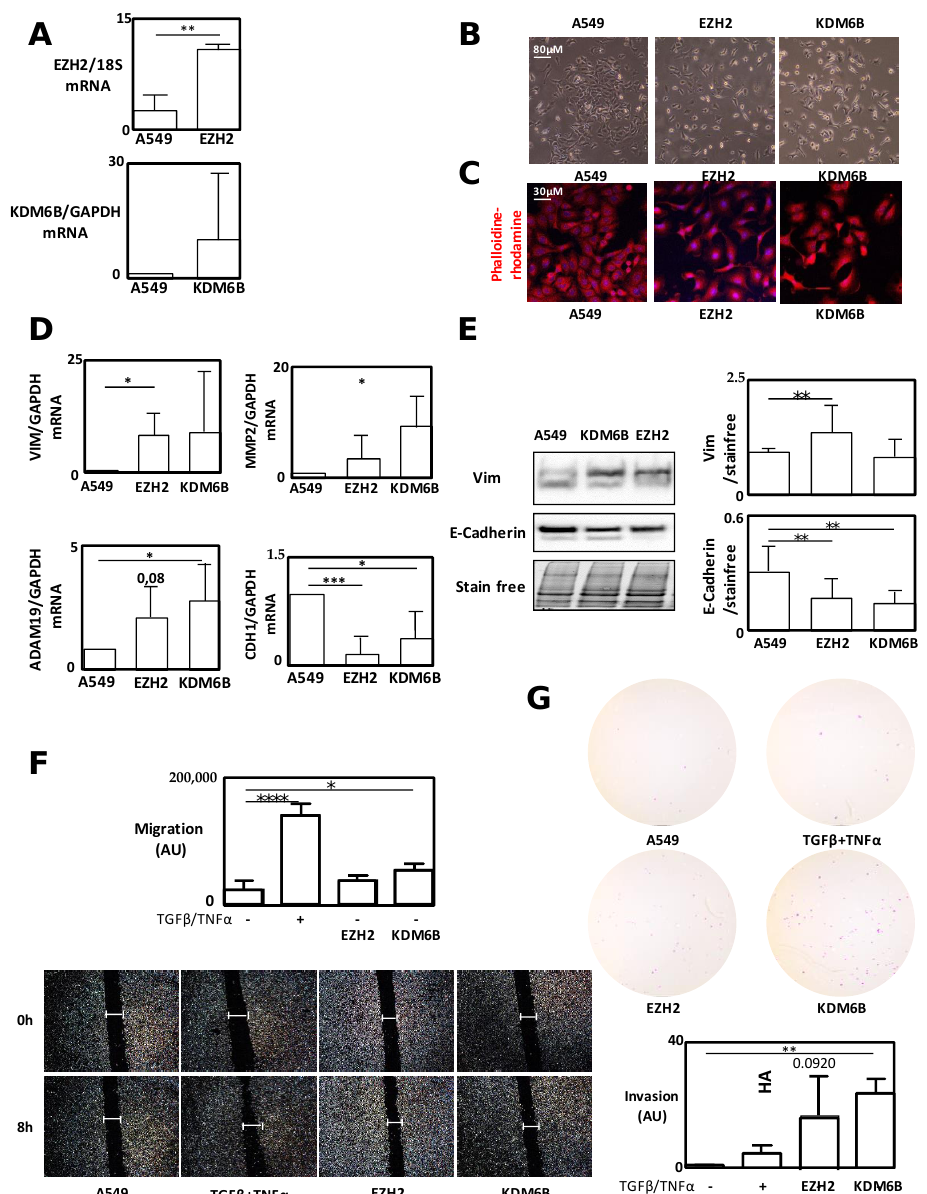
Figure 2. Overexpression of EZH2 and KDM6B induced EMT. ( A ) mRNA levels of EZH2 and KDM6B after stable transfection of A549 with EZH2- or HA-KDM6B-expressing vectors. ( B ) Representative images showing the phenotype of A549 WT cells and A549 cells overexpressing EZH2 or KDM6B (EVOS ™ 10 × Objective). ( C ) Phalloidin-rhodamin staining of A549 WT or A549 cells overexpressing EZH2 or KDM6B. ( D ) Quantification of Vimentin , CDH1 , ADAM19 , and MMP2 expression levels using qRT-PCR in A549 cells treated with TGF β / TNF α or in cells overexpressing EZH2 or KDM6B. ( E ) Western-blot analysis showing a decrease in E-Cadherin expression in A549 cells overexpressing KDM6B.( F )WoundhealingexperimentsinA549cellstreatedwithTGF β / TNF α orincellsoverexpressing EZH2 or KDM6B and the relative quantification of the e ff ects observed (EVOS ™ 4 × Objective). ( G ) Invasion tests in A549 cells treated with TGF β / TNF α or in cells overexpressing EZH2 or KDM6B (EVOS ™ 4 × Objective). * = 0.01 < p < 0.05; ** = 0.005 < p < 0.01; *** = 0.001 < p < 0.005; **** = p <